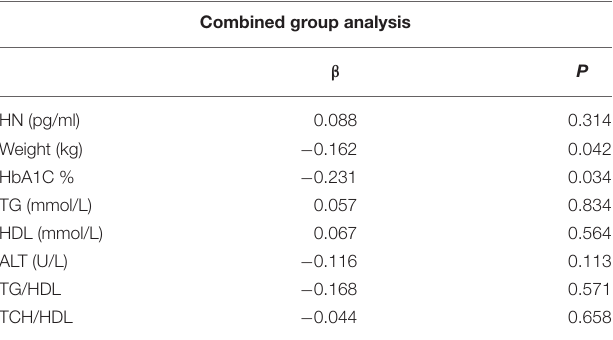
TABLE 2F | Multiple linear regression analysis of variables that showed significant association with ADP. Combined group